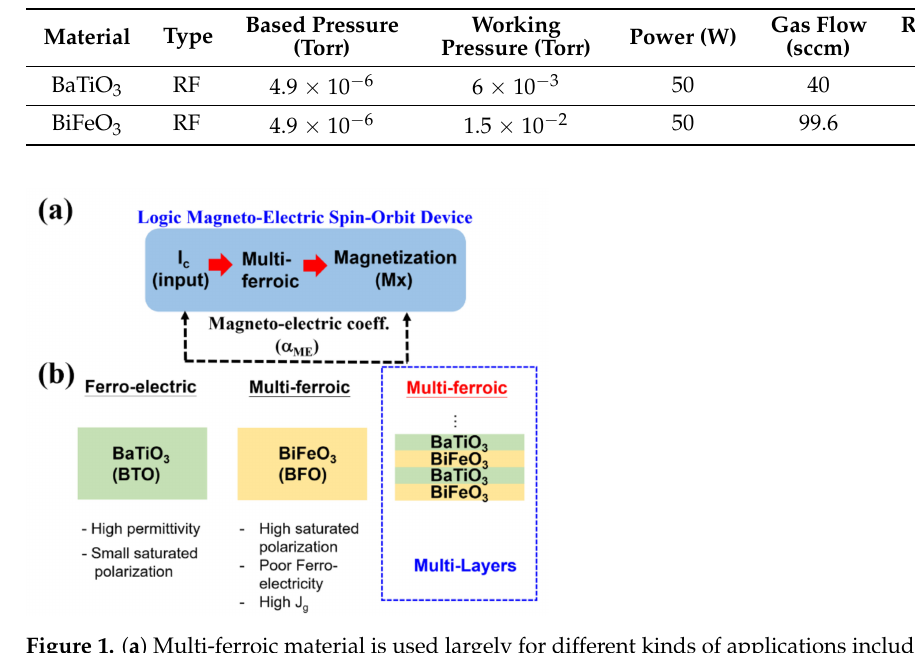
Figure 1. ( a ) Multi-ferroic material is used largely for different kinds of applications including Logic Magneto-Electric Spin-Orbit (MESO) devices and ( b ) BaTiO 3 (BTO) and BiFeO 3 (BFO) are the well- known ferroelectric and multi-ferroic materials, respectively. In this work, we propose multi-layer BFO/BTO thin film structures with superior multi-ferroic